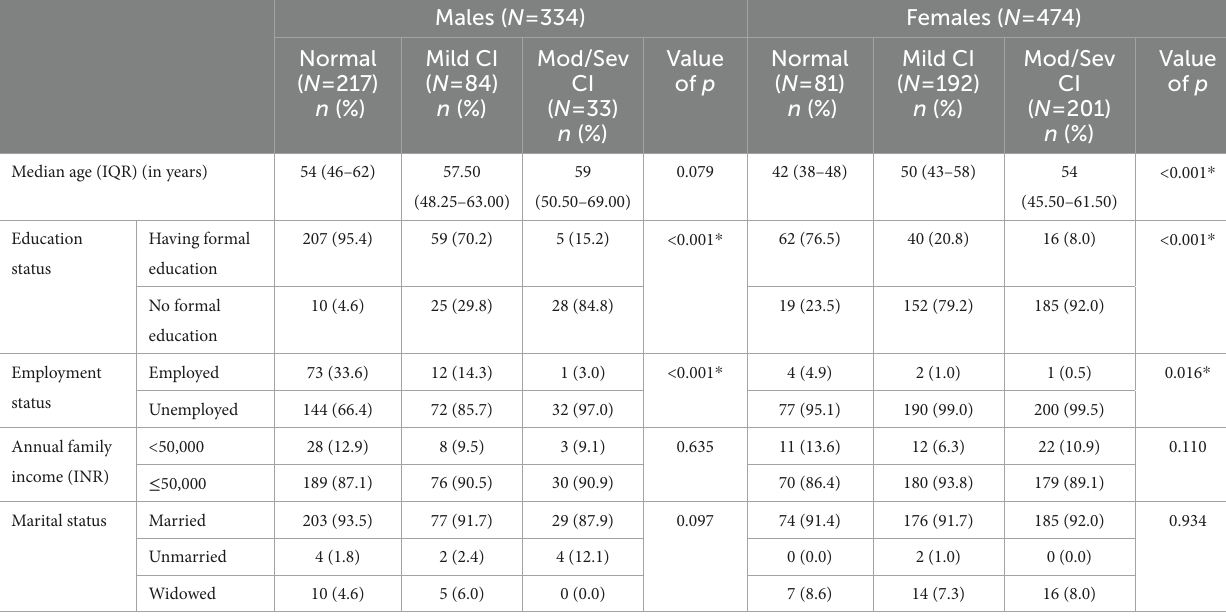
TABLE 1 Sex-wise distribution of sociodemographic variables with respect to cognitive